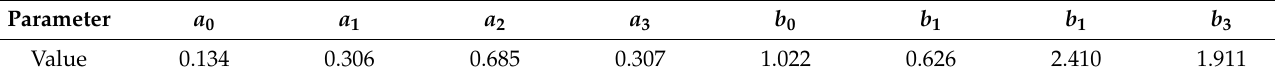
Table 3. Fitting results of the parameters h and b .